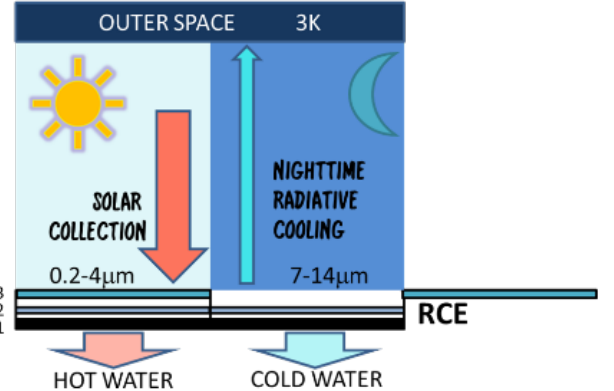
Figure 2. Radiative Collector and Emitter (RCE) working under solar collection mode (SC) during day time and radiative cooling mode during night-time. (1) absorber/emitter, (2) wind-shield (plastic film), and (3) glass cover.